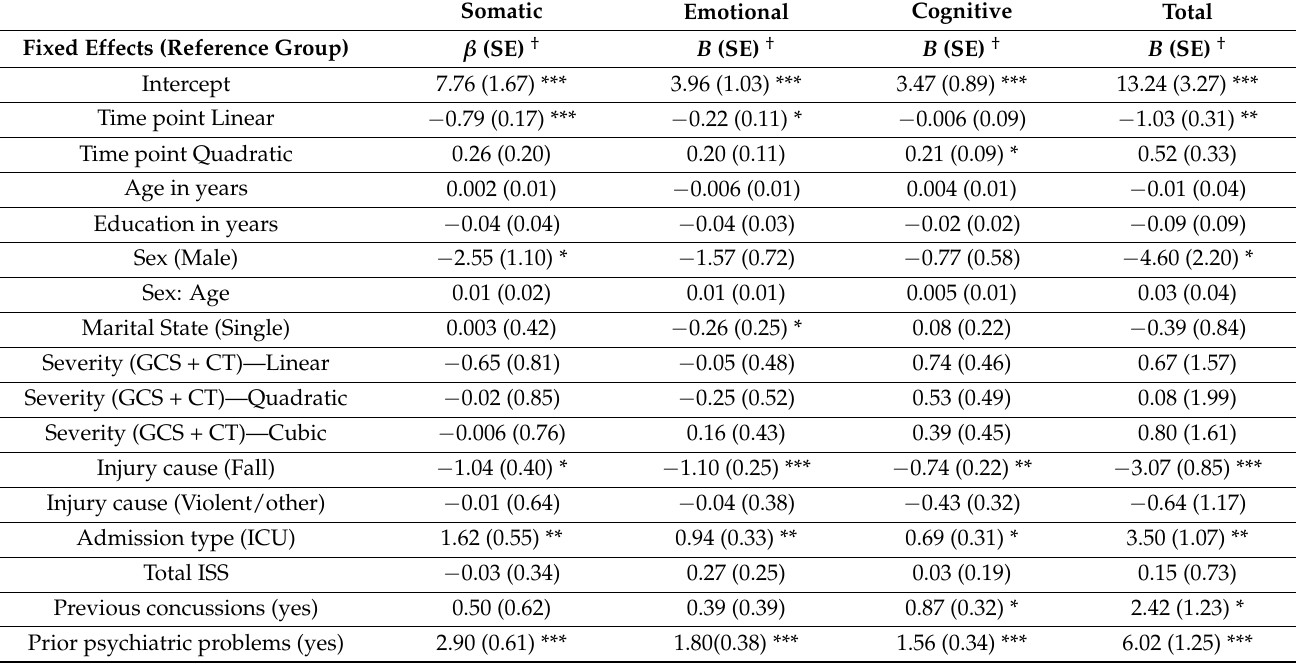
Table 4. Demographic and injury predictors of factor score trajectories across 3, 6 and 12 months.